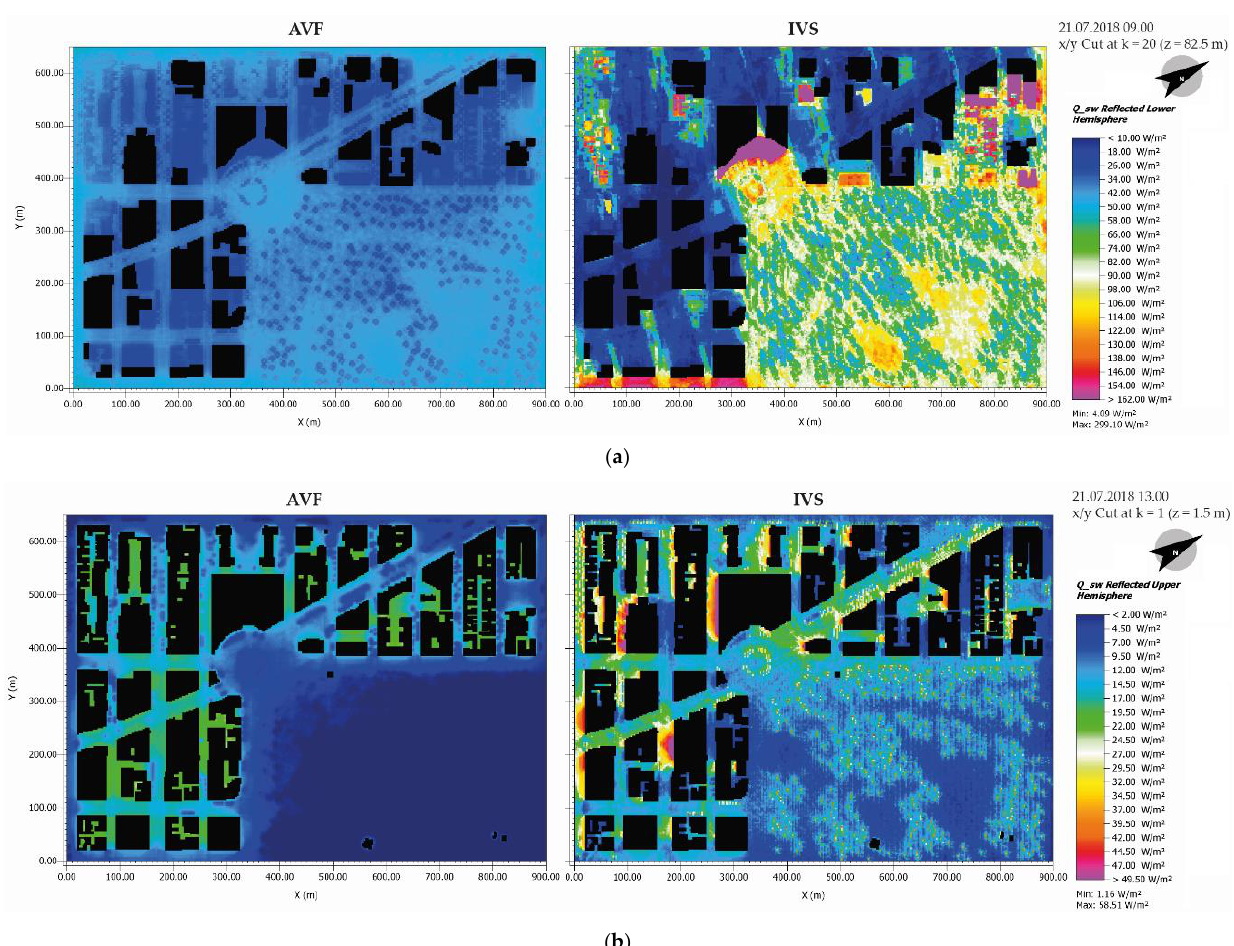
Figure 7. Comparison of proof-of-concept simulation results between AVF and IVS for reflected shortwave radiation received from the lower hemisphere at 09.00 in a height of 82.5 m ( a ) and for reflected shortwave radiation received from the upper hemisphere at 13.00 in a height of 1.5 m ( b ), respectively.